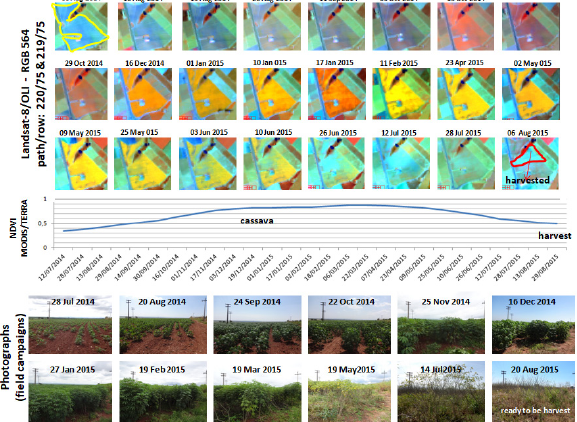
Figure 4. Field and satellite data of an area cultivated with cassava. Source: Parts of the figure was adapted from Formaggio and Sanches (2017).